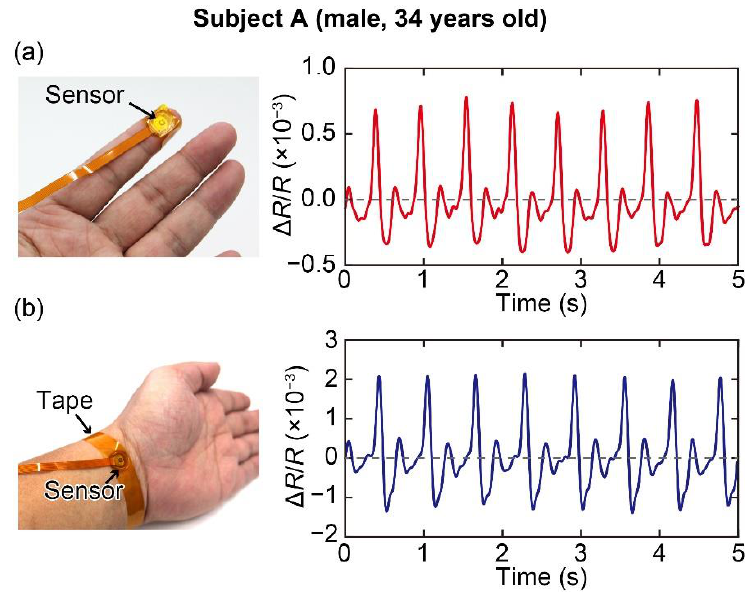
Figure 4. ( a ) Measurement of pulse wave at the tip of the subject’s index finger. ( b ) Measurement of pulse wave at the wrist of the subject.